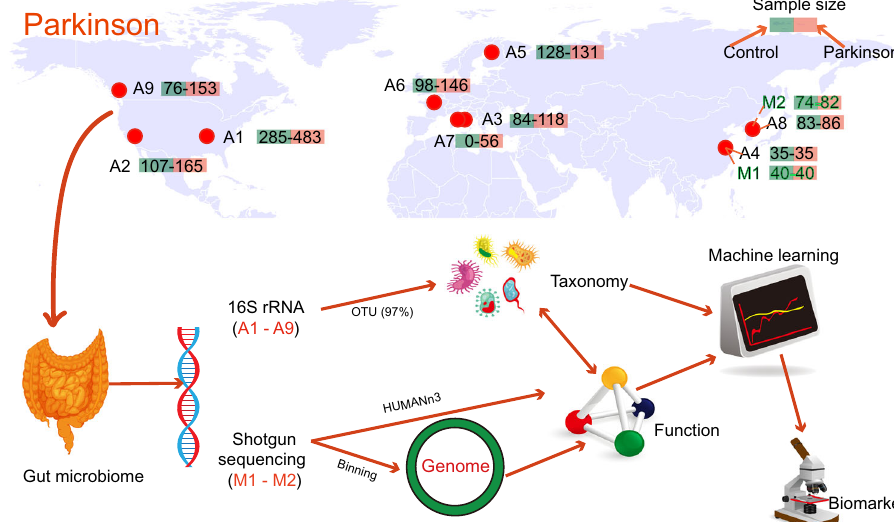
Fig. 1 Study design. Nine datasets (A1 – 9) including 2269 16S rRNA gene samples and two datasets (M1-M2) including 236 shotgun metagenomic samples were collected from 11 studies. Taxonomy was inferred from 16s rRNA gene based on the operational taxonomic unit (OTU), the function was inferred from shotgun sequencing, and the genome was obtained by binning (metagenome-assembled genomes). Finally, the biomarker was found using machine